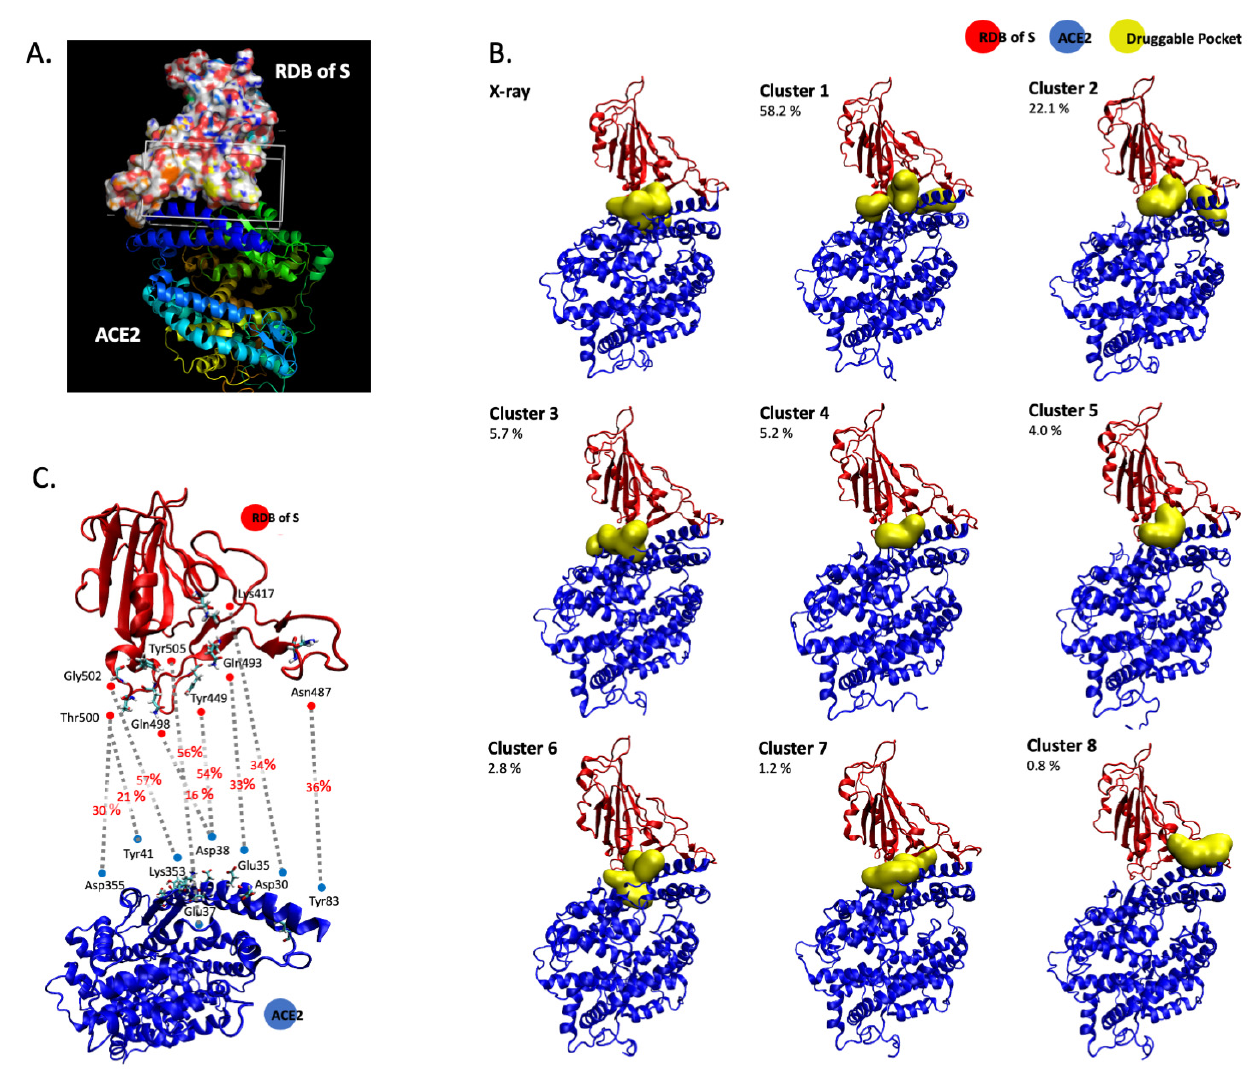
Figure 1. Computational modelling of the severe acute respiratory syndrome coronavirus 2 (SARS-CoV-2)/ACE2 complex. The S RDB-ACE2 complex has been modelled using molecular dynamics calculations ( A ). In the image the surface representation represents the RDB of the S protein, while the ribbon representations describes ACE2. Druggable binding pockets at the RDB-ACE2 interface identified with FPocket in the X-ray structure (6M0J) and in the 8 representative structures obtained from the cluster analysis performed on the 400 ns MD simulation are reported in ( B ). The values reported refer to the percentage of structures within each cluster in the MD simulation. Dominant hydrogen bonds and participating residues at the RDB/ACE2 interface with indication of the percentage of MD structures in which they are formed are reported in ( C